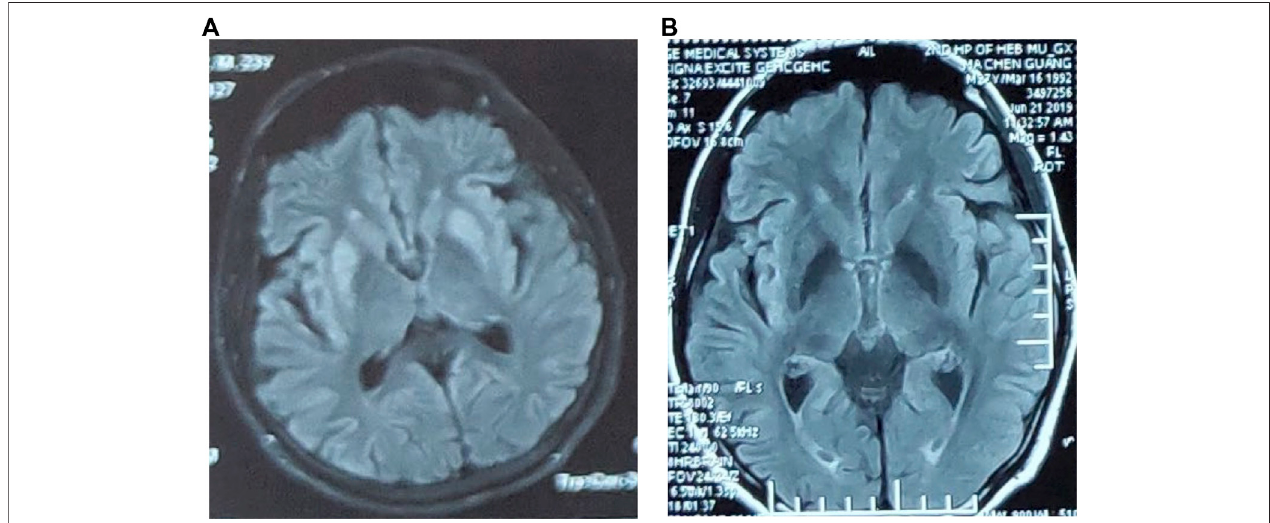
FIGURE2 | CES identi fi ed one heterozygous deletion mutation. M1: c.404_406del:p.G135del and one heterozygous missensemutation. M2: c.632C > T:p.T211I. Sanger sequencing results showed that the mutations M1 and M2 were inherited from the father and mother, respectively.